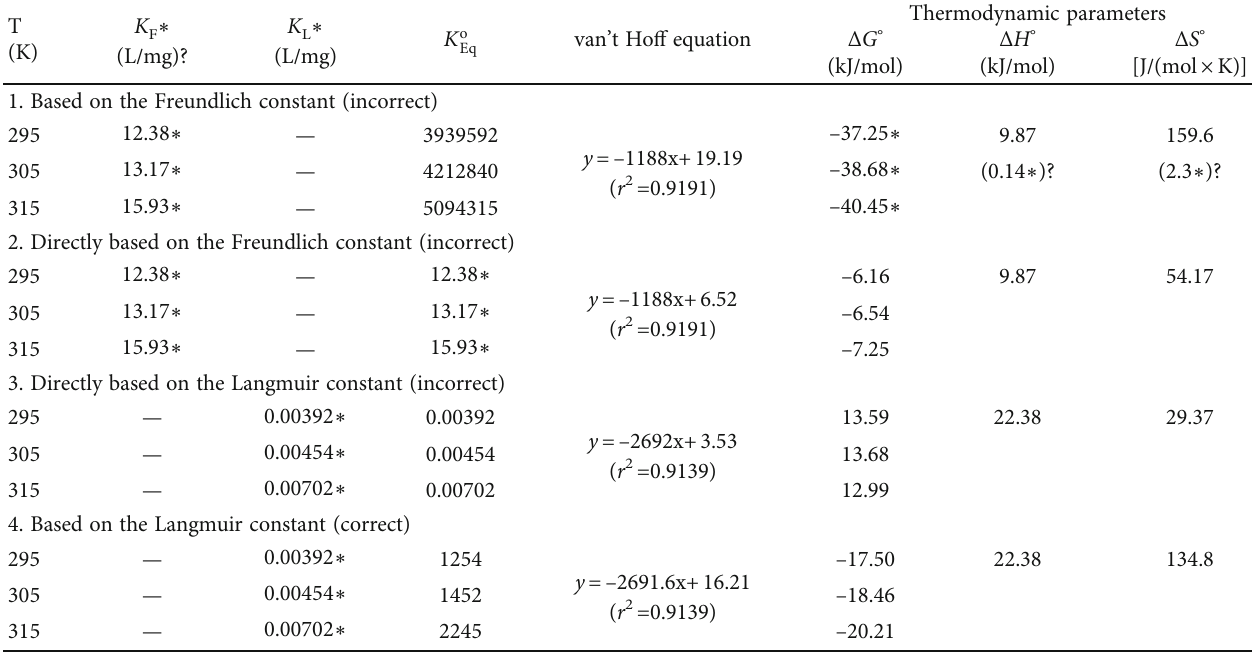
Table 8: Thermodynamic parameters of the adsorption process of methylene blue onto